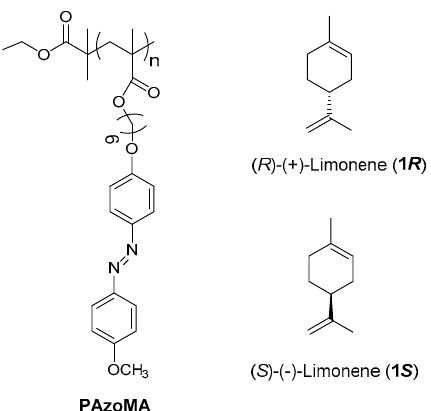
Scheme 1. Illustration of the chemical structures of poly(6-[4-(4-methoxyphenylazo) phenoxy]